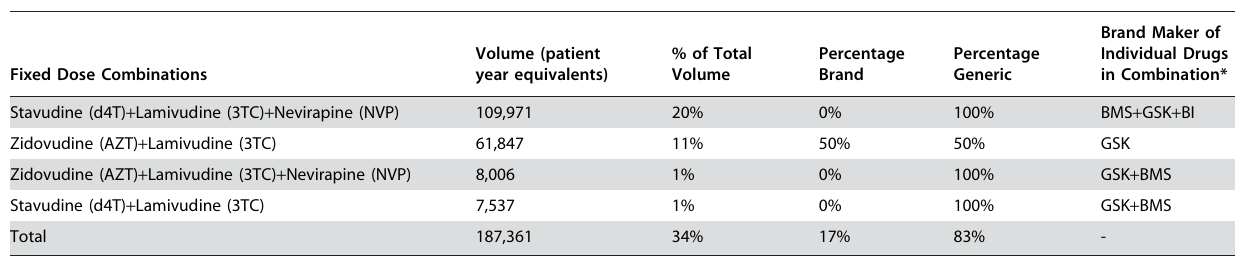
Table 2. First Line Fixed Dose Combination Antiretroviral Drugs .. ... .... ... ... .... ... ... .... ... ... .... ... ... .... ... ... .... ... ... .... ... ... .... ... ... .... ... ... .... ... ... .... ... ... .... ... ... .... ... ... .... ... ...